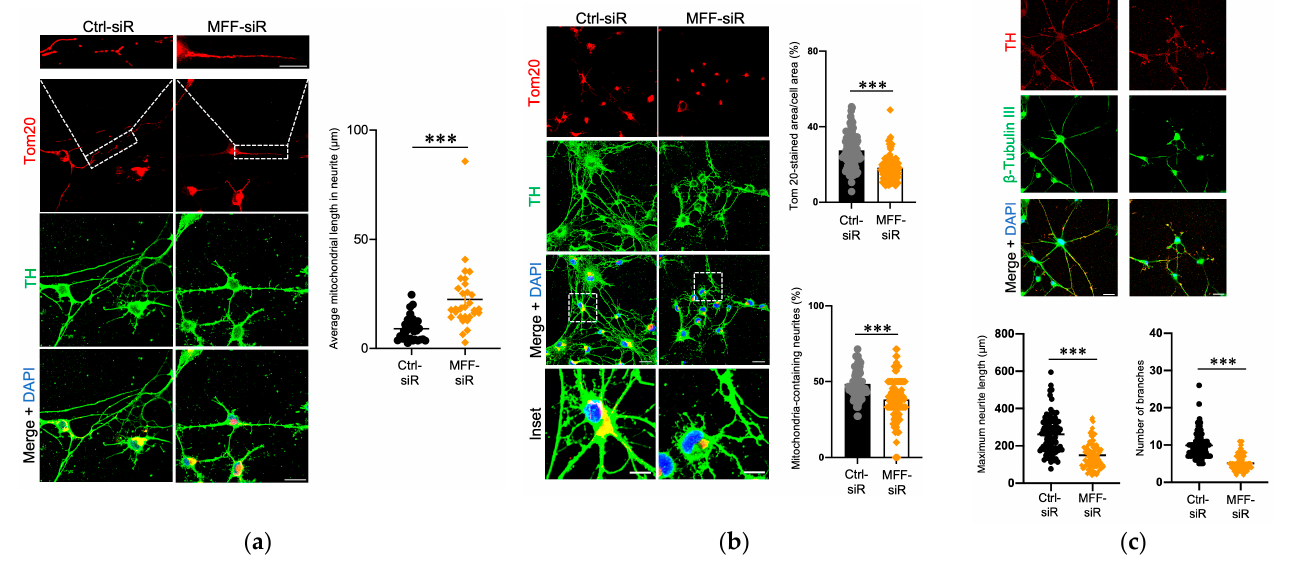
Figure 1. MFF knockdown induced mitochondrial elongation and developmental defects in the neu- rites of DNs. Stem cells from human exfoliated deciduous teeth were transfected with negative con- trol- (Ctrl-siR) and MFF-siRNA (MFF-siR) and differentiated into DNs. ( a , b ) The DNs were stained with anti-Tom20 and anti-TH antibodies and counterstained with DAPI. ( a ) Mitochondrial length of neurites was measured for 10 mitochondria in each group. Scale bar = 20 μ m. The boxed regions on the Tom20-stained images are shown at a greater magnification in the upper panels. Scale bar = 10 μ m. The mean ± SEM was taken from three independent experiments. *** p < 0.001. ( b ) Tom20-stained area per cell area and the percentage of mitochondria-containing neurites were measured for 30 cells in each group. Scale bars = 25 μ m. The boxed regions on the merged images are shown at a greater magnification in the lower panels. Scale bars = 10 μ m. The mean ± SEM was taken from three independent experiments. *** p < 0.001. ( c ) The DNs were stained with anti- β -tubulin III, anti-TH antibodies, and DAPI. Scale bars = 25 μ m. Maximum neurite length and number of branches per cell were examined. The mean ± SEM was taken from three independent experiments. *** p < 0.001.